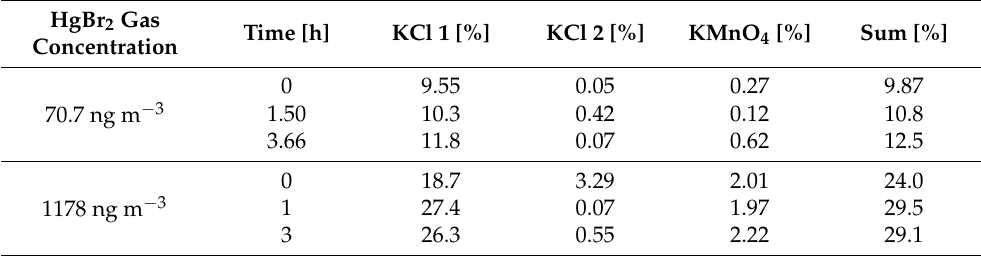
Table 4. The calibrator output composition during a time-trend experiment using 70.7